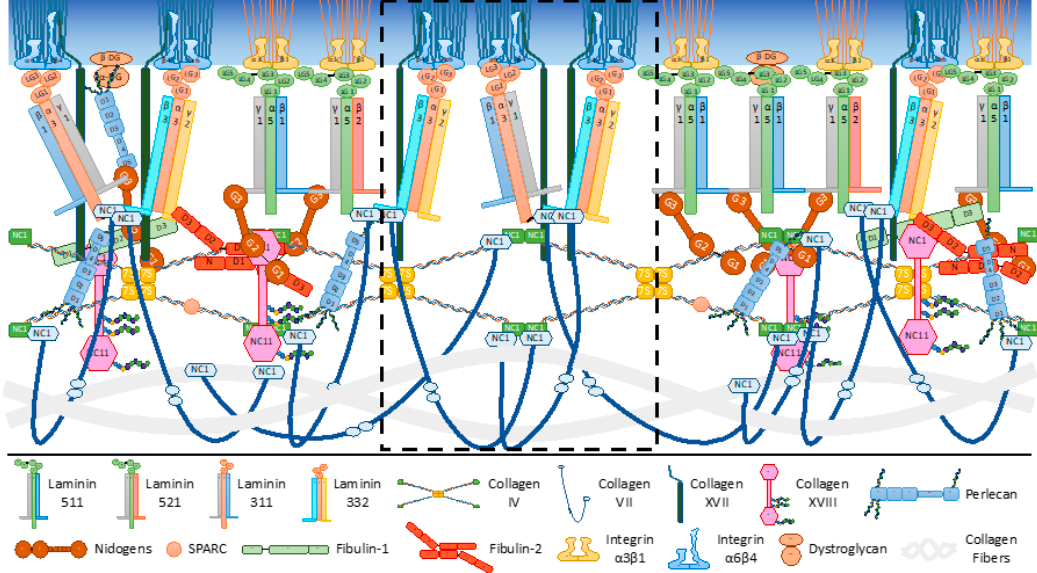
Figure 2. Dermal-epidermal junction components, receptors, and intermolecular binding. The epidermal basementmembranecontainslaminins,nidogens, collagens IV, VII, XVII, and XVIII, perlecan, and fibulins. Majors receptors and other cell surface binding molecules include integrins and dystroglycan. Collagen IV and laminins 511 / 521 form networks connected to one another by nidogens and perlecan. Other interacting partners and protein domains involved in molecular interactions are indicated. A focus on the extracellular matrix components of anchoring complexes and their interactions are presented in the central dotted frame. Laminin-332 and -311, collagen VII and XVII, and α 6 β 4 integrin are shown. Laminins of the dermal-epidermal junction interact with keratinocytes receptors through the C-terminal laminin globular (LG) domains of their α chain. Non-collagenous (NC); globule (G), sedimentation coe ffi cient 7S (7S), domain (D), N-terminal domain (N); β sub-unit of dystroglycan ( β -DG); α sub-unit of dystroglycan ( α